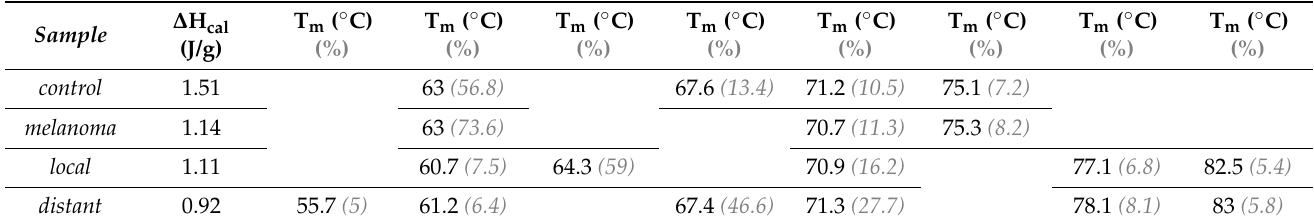
Table 7. Contribution of deconvolved transitions from Figure 4 to the total enthalpy change, gray numbers represent the relative participation to the total change (based on instrument error, only those compounds are used which have a higher than 5% change, recently evaluated).